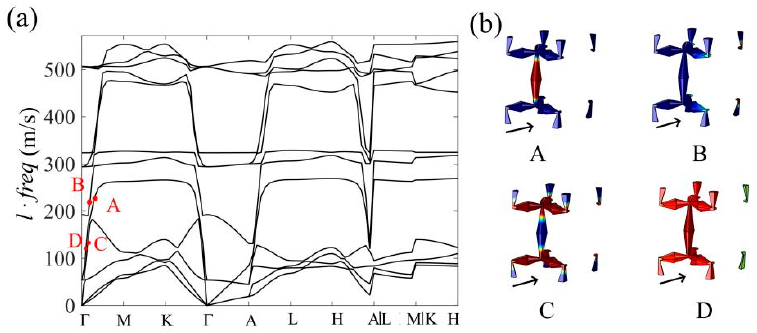
Figure 4. The band structures ( a ) and specific modes ( b ) of the primitive cell with η v = 0.